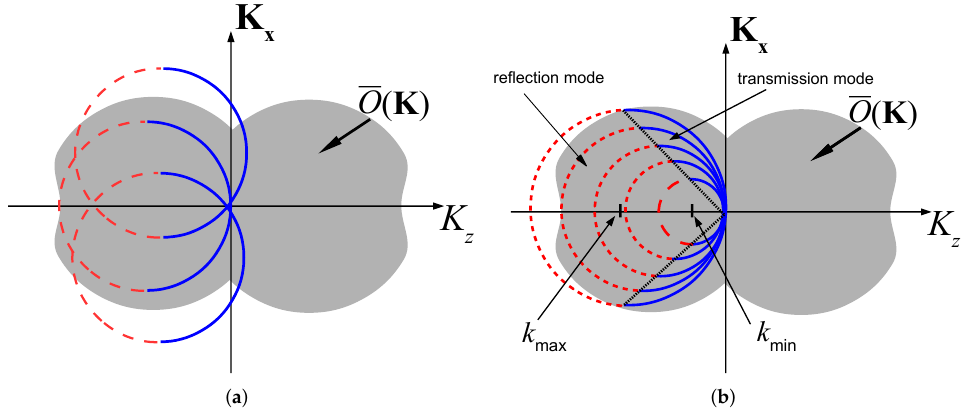
Figure 2. K -space reconstruction. ( a ) Angular diversity reconstruction: Changing the direction of illumination ◦ κ i and measuring the transmitted data only provides a coverage of the K − space within √ a sphere of radius 2 k [5]. ( b ) Frequency diversity reconstruction: Changing the excitation frequency for a single illumination direction ◦ κ i provides coverage of the K − space as indicated. The figure is plotted for ◦ κ i = ◦ z